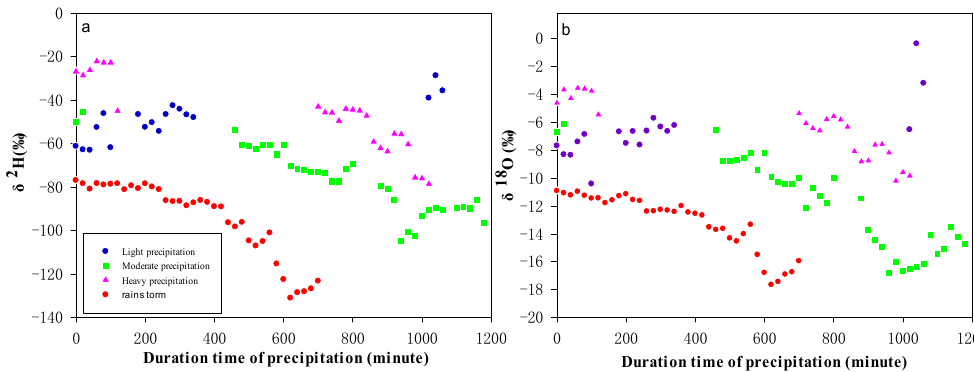
Figure 6. Characteristics of the precipitation events in light, moderate, heavy and rainstorm precipitation. ( a ) the variation of hydrogen isotope in the precipitation events ( b ) the variation of oxygen isotope in the precipitation